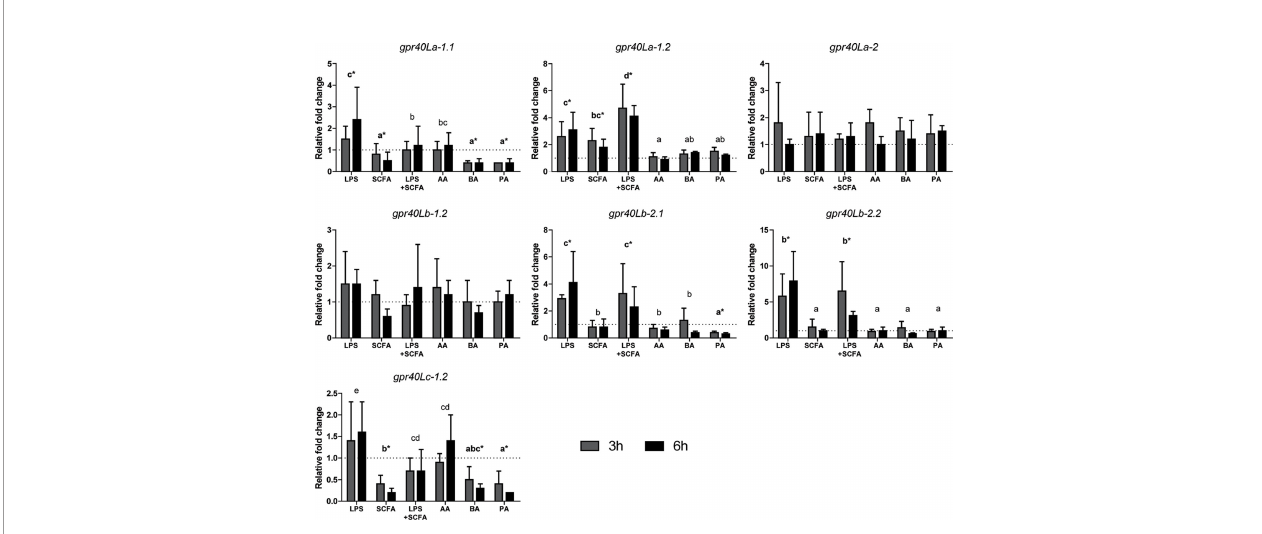
FIGURE 7 | SCFAs regulate the expression of several gpr40L receptors ex vivo stimulated head kidney leukocytes. Gene expression after 3 (grey bars) and 6 (closed bars) h of stimulation with LPS (30 µg/ml), SCFA mix (2.5 mM), LPS, and SCFA mix or the three SCFAs at the concentration they were included in the mix; acetate 1.55 mM (AA), butyrate 0.25 mM (BA), and propionate 0.765 mM (PA), compared to unstimulated HKLs (dotted line). Bars indicate mean ± SD of n = 5 experiments performed independently. Signi fi cant differences between groups were assessed by the linear mixed model followed by the Bonferroni post hoc test. Groups with different letters are statistically different from one another, where “ a ” indicates the lowest value; groups indicated with asterisk (*) are signi fi cantly different from unstimulated